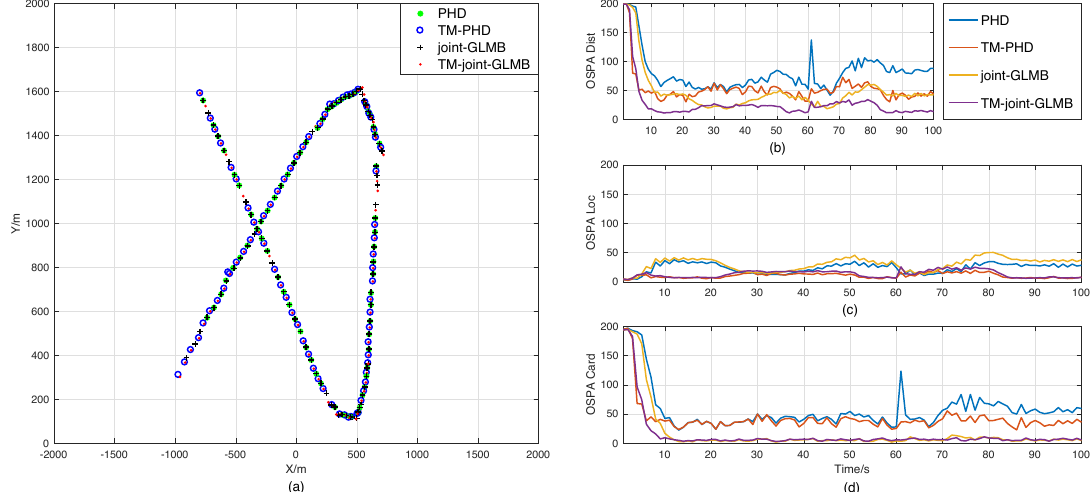
Figure 4. Result comparisons in Scenario 1. ( a ) Position estimations of the original random finite set (RFS)-based filters and the time-matching filters in one trial. ( b ) Optimal subpattern assignment metric (OSPA) errors. ( c ) Location components of OSPA. ( d ) Cardinality components of OSPA. PHD, probability hypothesis density; GLMB, generalized labeled multi-Bernoulli